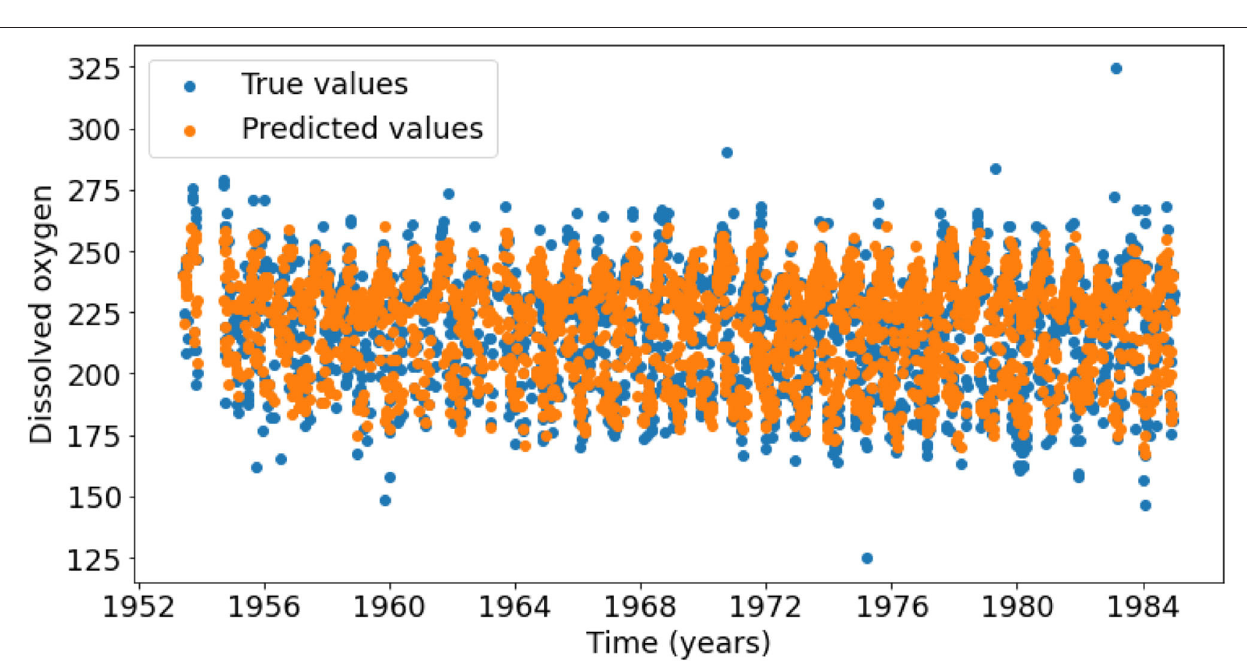
FIGURE 6 | Timeseries of the true (blue points) and predicted (orange points) dissolved oxygen